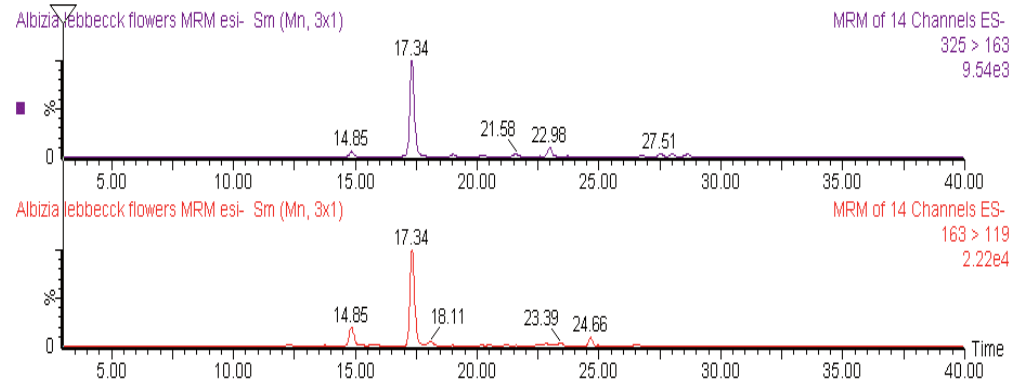
Fig. 1: MRM chromatograms of coumaric acid-hexosides. It is possible to note at least two isomers (14.85 and 17.34), identified through the loss of hexose moiety 325>163 and further fragmentation of coumaric acid 163>119.